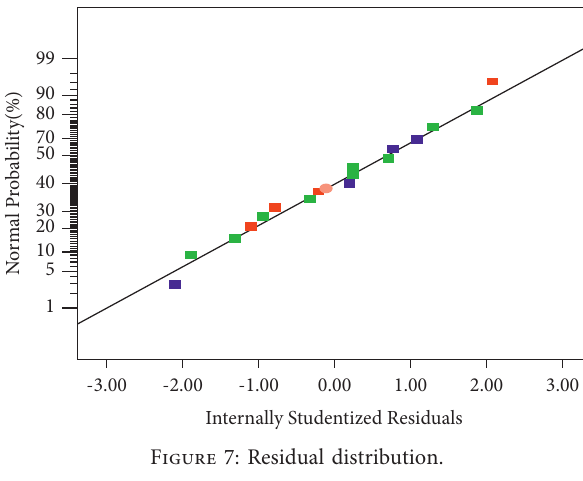
Figure 7: Residual distribution.